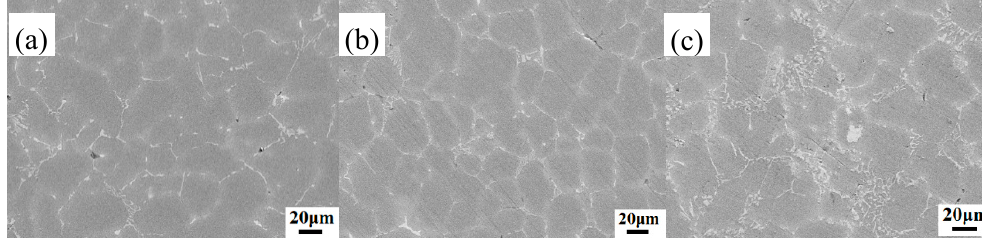
Figure 5. Scanning electron (SEM) images of TiB 2 /7075 aluminum matrix composites with different TiB 2 contents: ( a ) 3.0 wt. %, ( b ) 4.5 wt. % and ( c ) 6 wt. %.